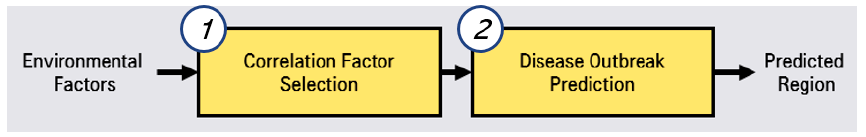
Figure 1. Two-phase approach of prediction system for hepatitis A.